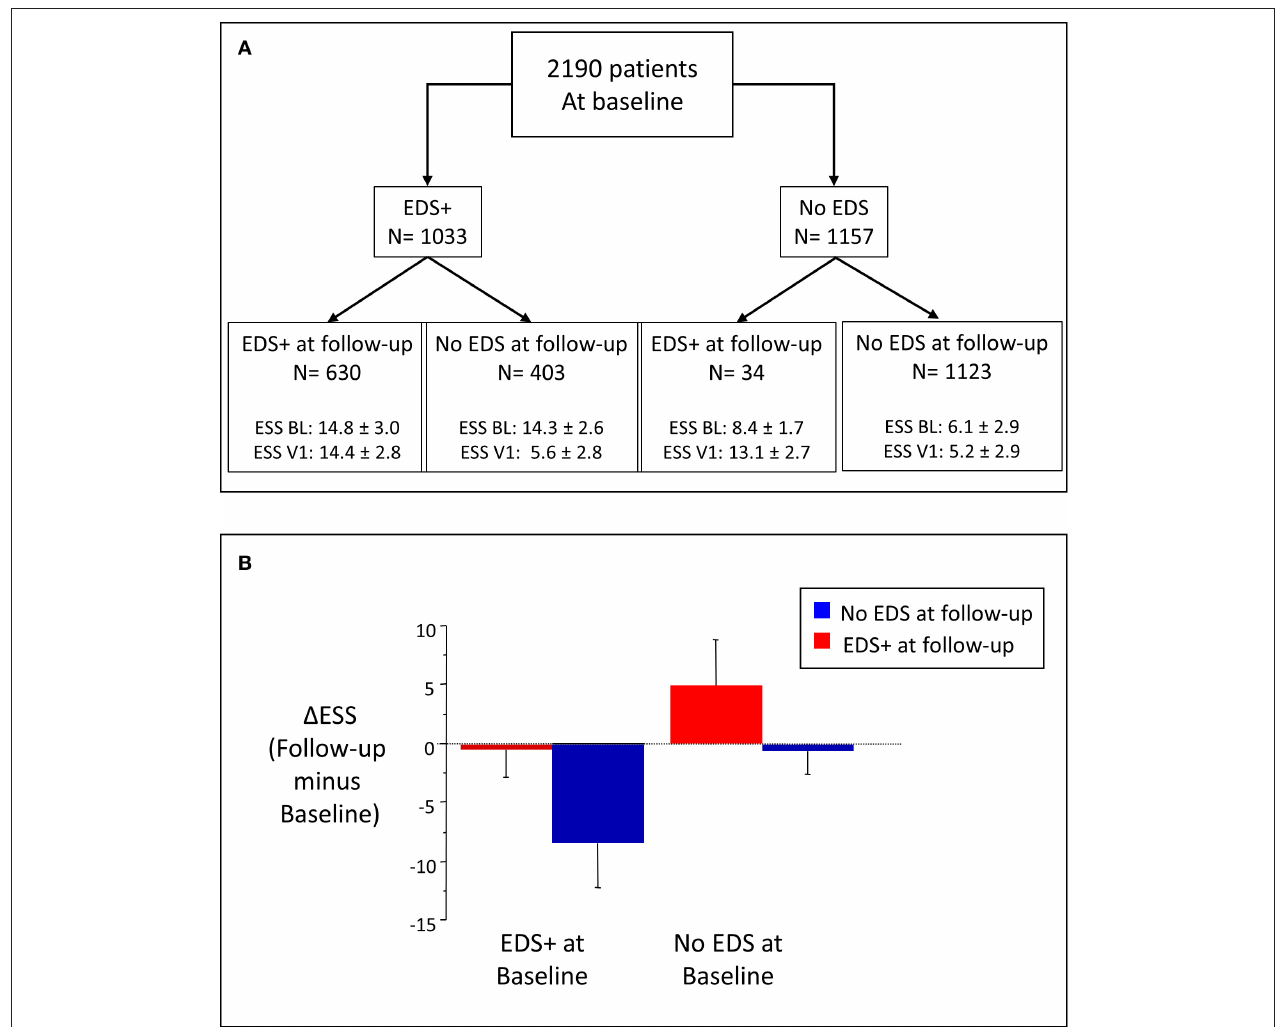
FIGURE 3 | (A) Stratification of patients in four groups, according to occurrence of EDS at baseline and follow-up. EDS + : EDS present; BL: Baseline; V1: first follow-up visit. (B) Change in EDS ( 1 EDS) in the four groups; 1 EDS calculated as EDS at follow-up minus EDS at baseline.